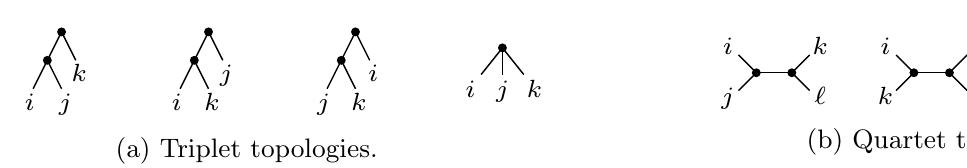
Figure 1. Different cases for triplet and quartet